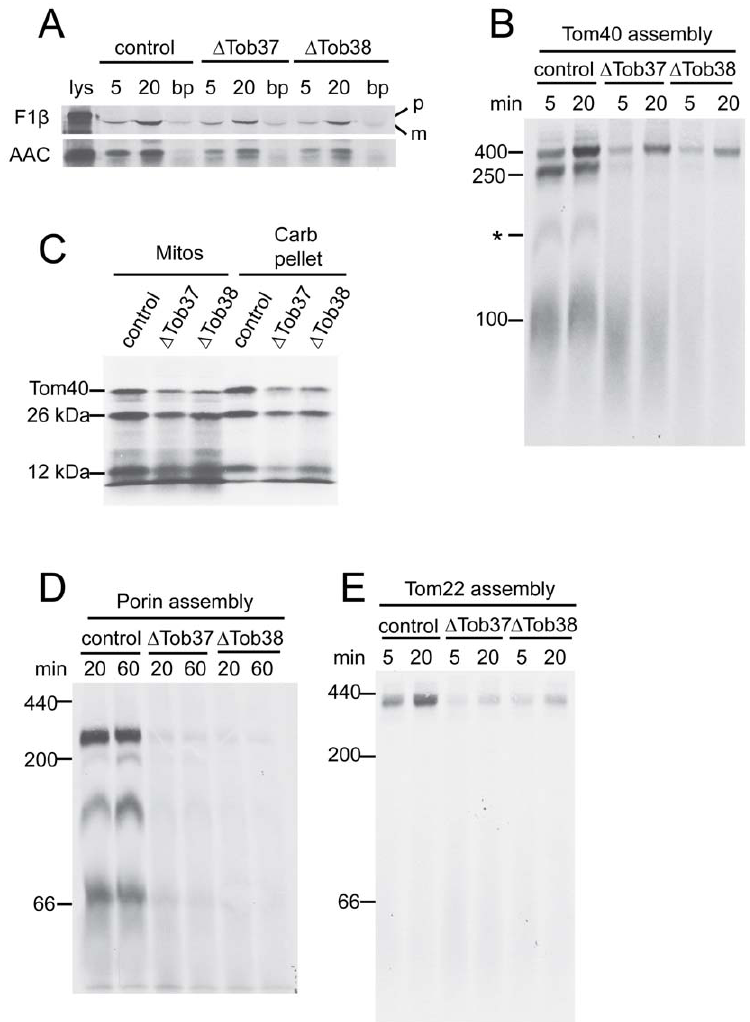
Figure 2. Import/assembly of mitochondrial precursor proteins into mitochondria deficient in Tob37 or Tob38. (a) Radiolabeled matrix precursor F 1 b and inner membrane precursor AAC were incubated (for 5 min or 20 min, as indicated) with mitochondria isolated from heterokaryotic strains (indicated at the top of the panel) grown in the presence of histidine and fpa to reduce levels of Tob37 or Tob38 in the respective mutants. Following import, mitochondria were subjected to SDS-PAGE. Proteins were transferred to nitrocellulose membrane, and import was analyzed by autoradiography. (control, strain HP1; lys, 33% of the radiolabeled lysate added to each import reaction; bp, ‘‘bypass import’’ in mitochondria treated with trypsin to remove surface receptors prior to the import reaction; p, precursor protein; m, mature protein.) (b) Radiolabelled Tom40 precursor was incubated for 5 min and 20 min with mitochondria isolated from the strains indicated (top of panel) grown in the presence of histidine and fpa. Mitochondria were dissolved in 1% digitonin and subjected to BNGE. The proteins were transferred to PVDF membrane and analyzed by autoradiography. The size of the mature TOM complex (400 kDa), and assembly intermediates I (250 kDa) and II (100 kDa) are indicated on the left. * indicates an undefined band. (c) Tom40 was imported into mitochondria isolated from the strains indicated for 20 min. Following import, proteinase K was added to each import reaction for 15 min on ice. PMSF was added to inactivate the proteinase, each reaction was divided into equal halves, and mitochondria were pelleted. One half was suspended in SDS-PAGE cracking buffer (Mitos). The other half was suspended in sodium carbonate (pH 11.5) and incubated on ice for 30 min. The membrane sheets were pelleted and suspended in cracking buffer (Carb pellet). Both sets of reactions were subjected to SDS-PAGE and the proteins were transferred to nitrocellulose membrane and examined by autoradiography. The positions of Tom40 and the 26 kDa and 12 kDa fragments generated by proteinase K digestion are indicated. (d) As in panel B except that mitochondria were incubated with the radiolabeled precursor of porin. The numbers on the left indicate the position of molecular weight markers. (e) Assembly of Tom22. As in panel D, except mitochondria were incubated with radiolabeled